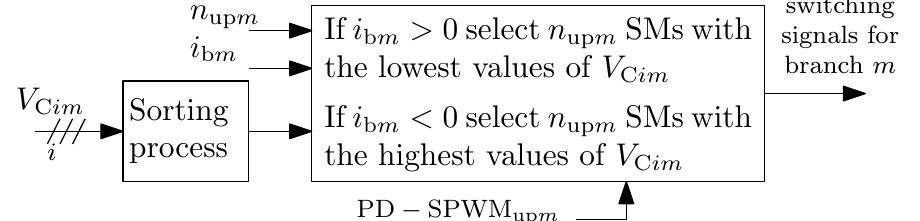
Figure 6. General flowchart of PD–SPWM modulation technique.